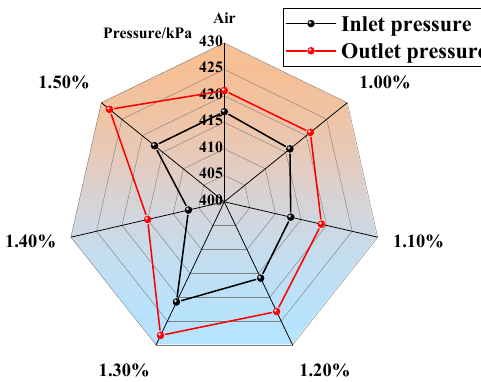
Figure 8. Inlet and outlet pressure.